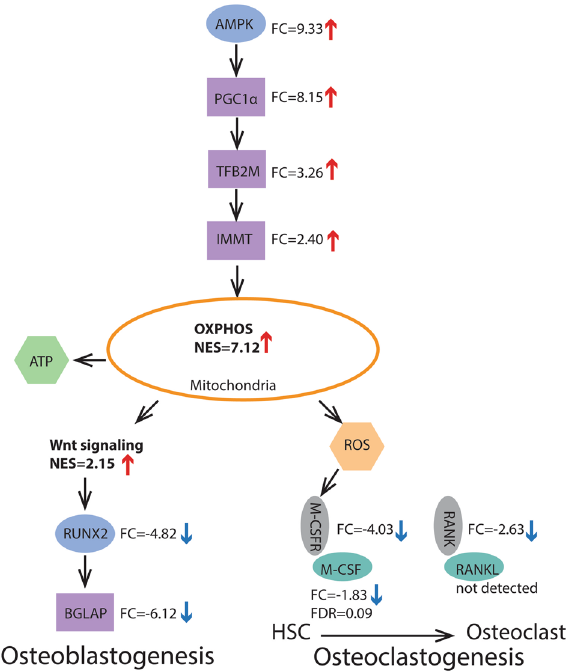
Figure 2. The AMPK/PGC1α stimulated mitochondrial oxidation (OXPHOS) in the regulation of mesenchymal stem cells osteoblastogenesis and osteoclastogenesis from hematopoietic stem cells (HSC) 33 in the bone/bone marrow of hibernating bears. Blue ovals—upstream stimulators, purple rectangulars—nuclear/ cytoplasmic communicators, green ovals—master mediators of osteoclastogenesis and grey ovals—receptors of the master mediators. FC—fold change in expression of gene during hibernation, red arrow—up-regulation, blue arrow—down-regulation. NES—GSEA normalized enrichment score (Tables 1, 2). M-CSF demonstrated tendency (FDR = 0.09) for down-regulation and expression of RANKL was not detected in the data set. ROS - reactive oxidative